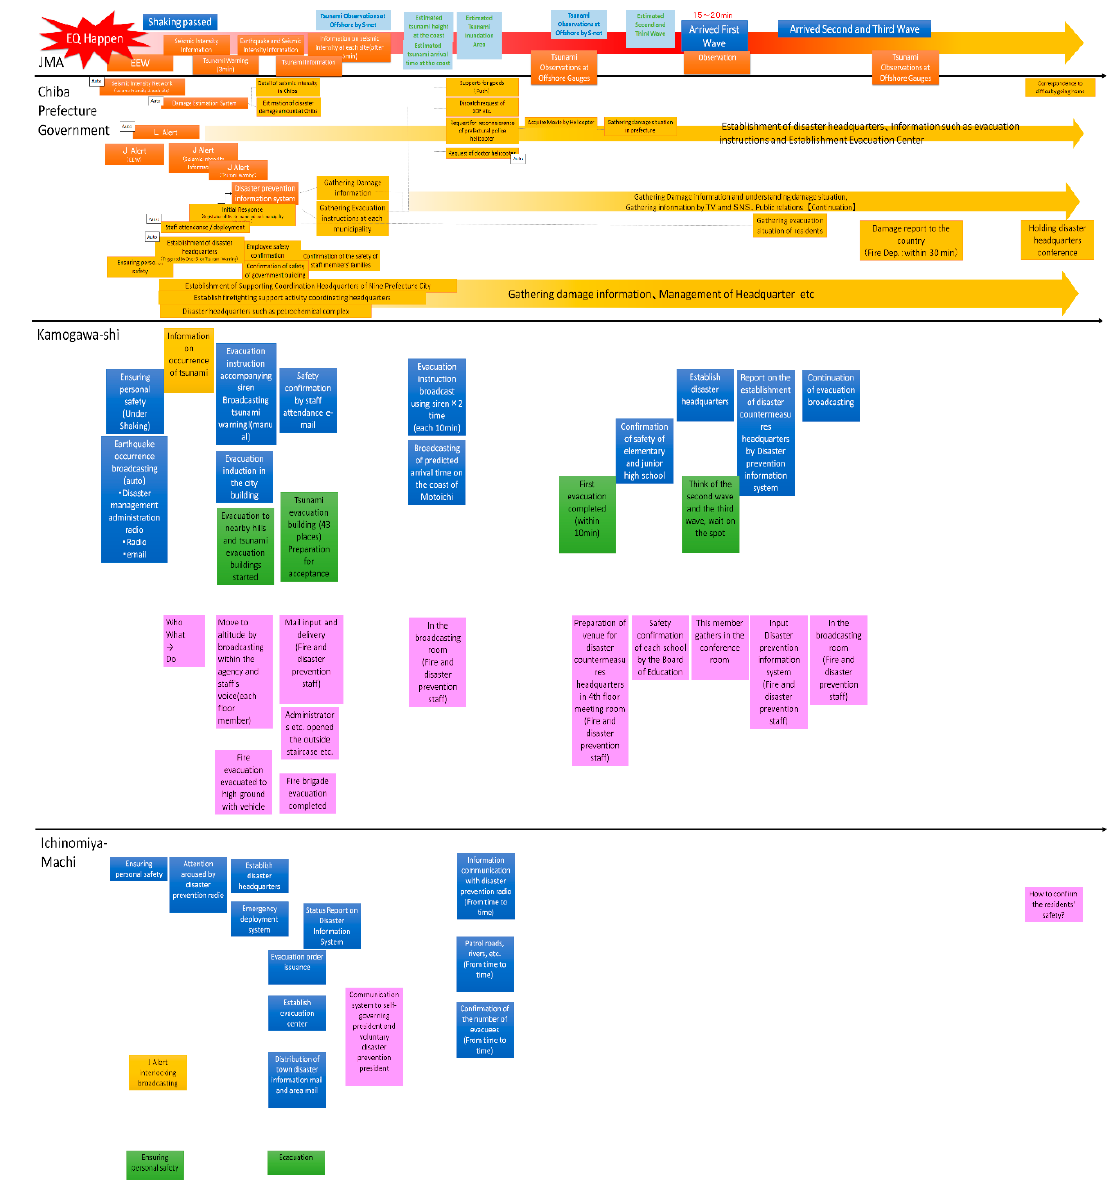
Figure 4. An example of a timeline of Kamogawa-shi and Ichinomiya-machi during a tsunami disaster. The upper part is the JMA information, the middle part is the flow of Chiba Prefecture’s response, the bottom part is the timeline created by the disaster response staff of Kamogawa-shi and Ichinomiya-machi. The blue rectangle shows the disaster response of Kamogawa-shi and Ichinomiya-machi, such as calling for evacuations throughout the city and establishing the disaster response headquarters. The green rectangle shows the residents’ actions. The pink rectangle shows who acts and what act is undertaken. EQ: Earthquake, EEW: Earthquake Early Warning, SDF: Japan Self-Defense Forces TV: Television, SNS: Social Networking Service